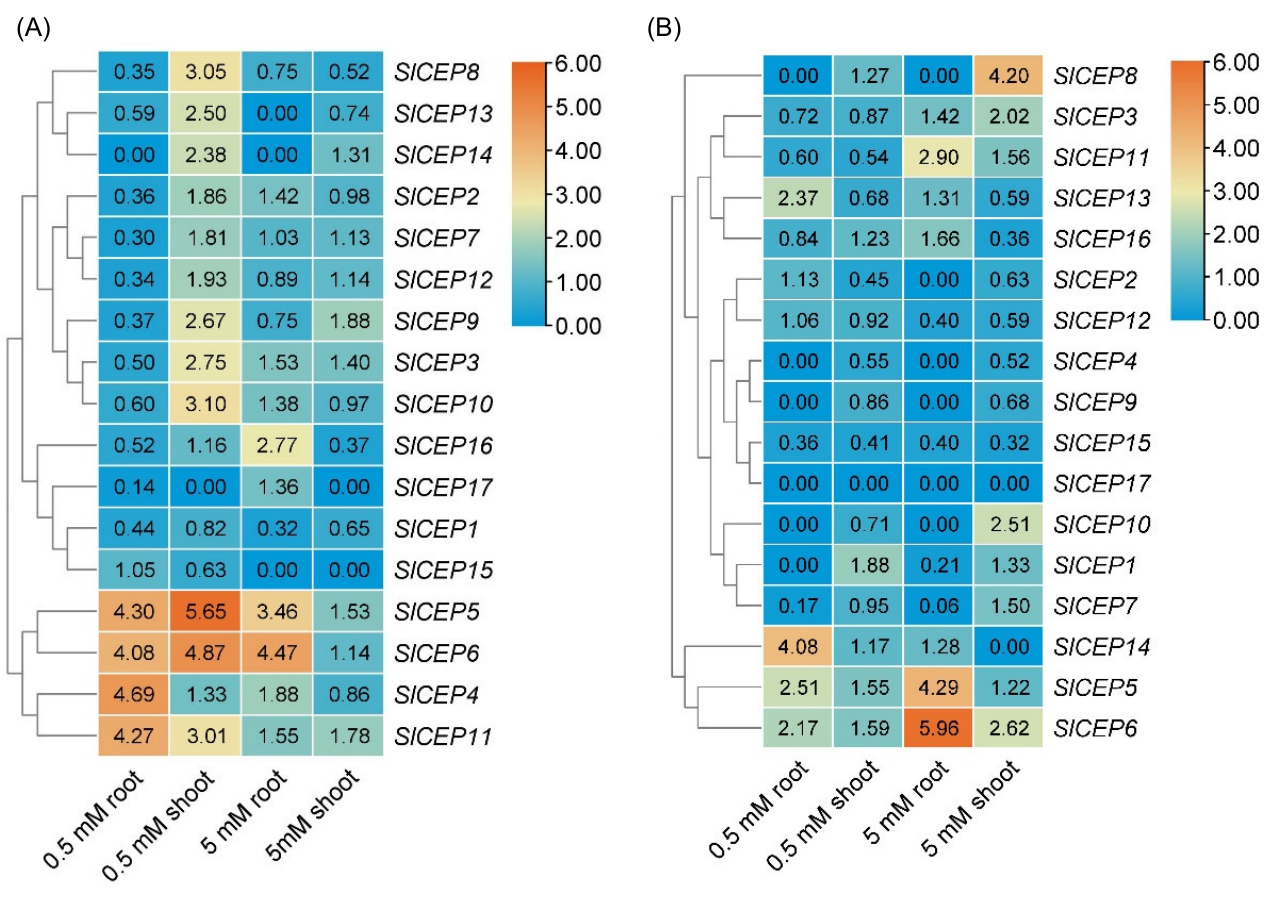
Figure 3. SlCEP genes expression are differentially regulated by nitrogen status in tomato roots and shoots. Expression levels of SlCEP genes in roots and shoots were quantified under low (0.5 mM) and high (5 mM) nitrate ( A ) and ammonium ( B ) treatment for 72 h. Relative expression levels of the genes were normalized to normal nitrogen condition, and the color represents log 2 values. The heatmap was generated by TBtools.